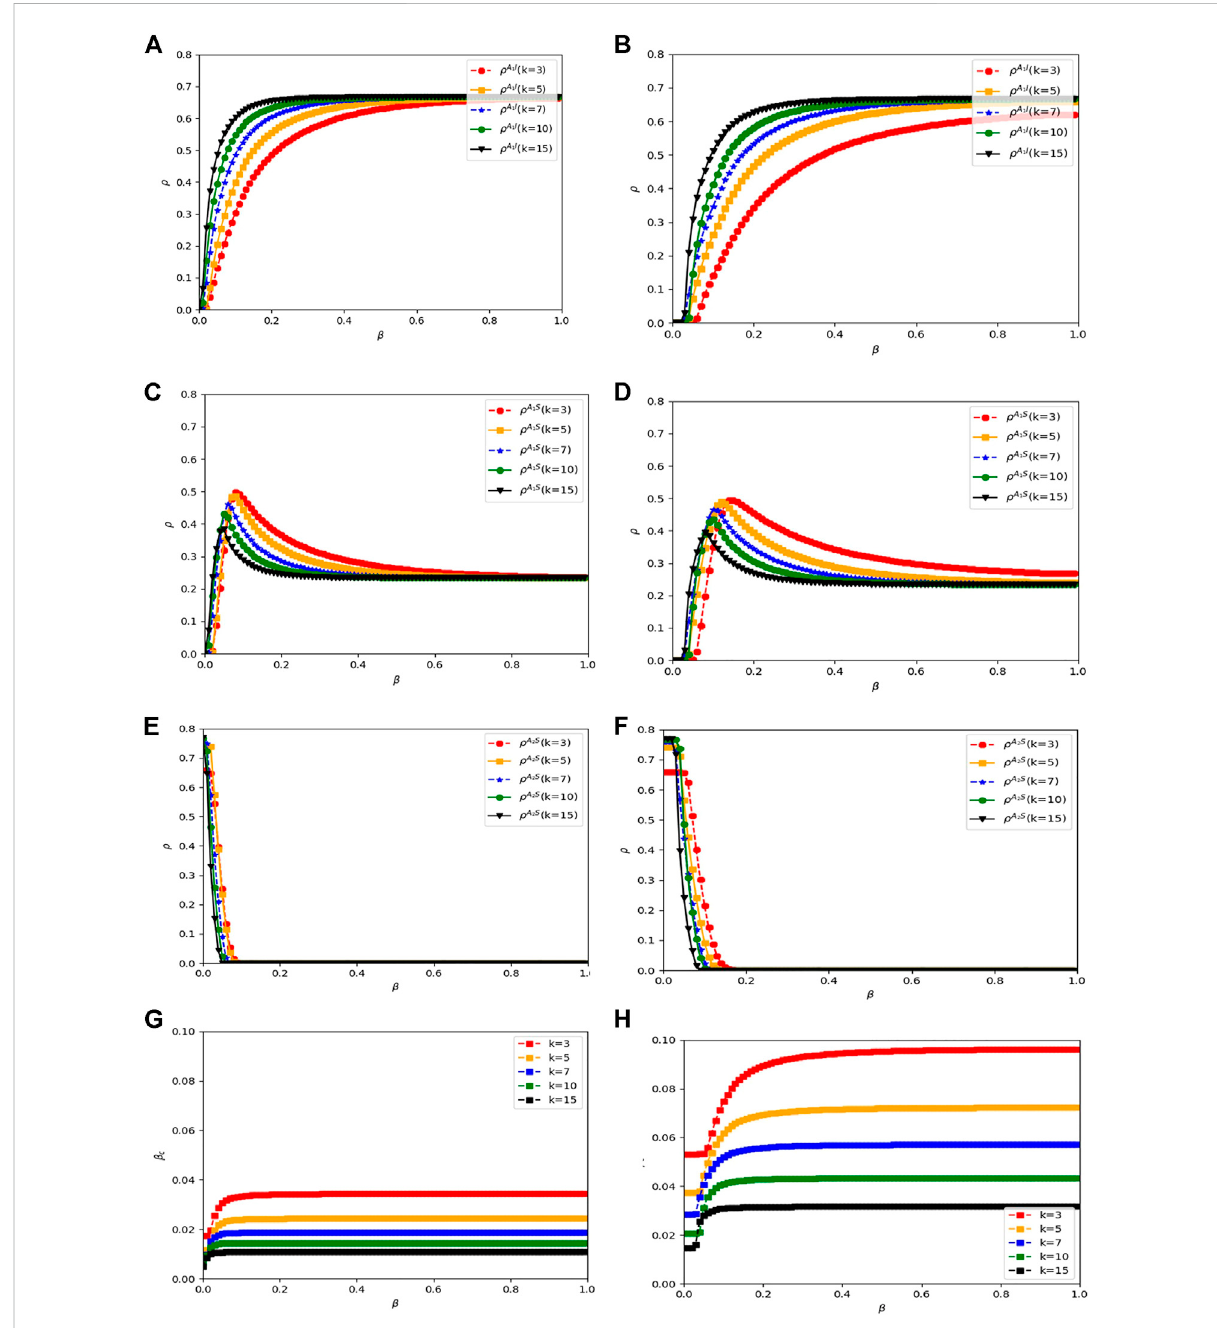
FIGURE 10 ρ A 1 I ( A , B) , ρ A 1 S ( C,D) , ρ A 2 S ( E,F) , and β c ( G , H ) as functions of β with the different node degree and different network structure. (A,C,E,G) are based ontheER-BAnetwork(theupperlayerandthelowerlayerareBAandERnetworks,respectively),and (B,D,F,H) arebasedontheER-ERnetwork(both the upper and lower layer are the ER network). Other parameters are the same as the default